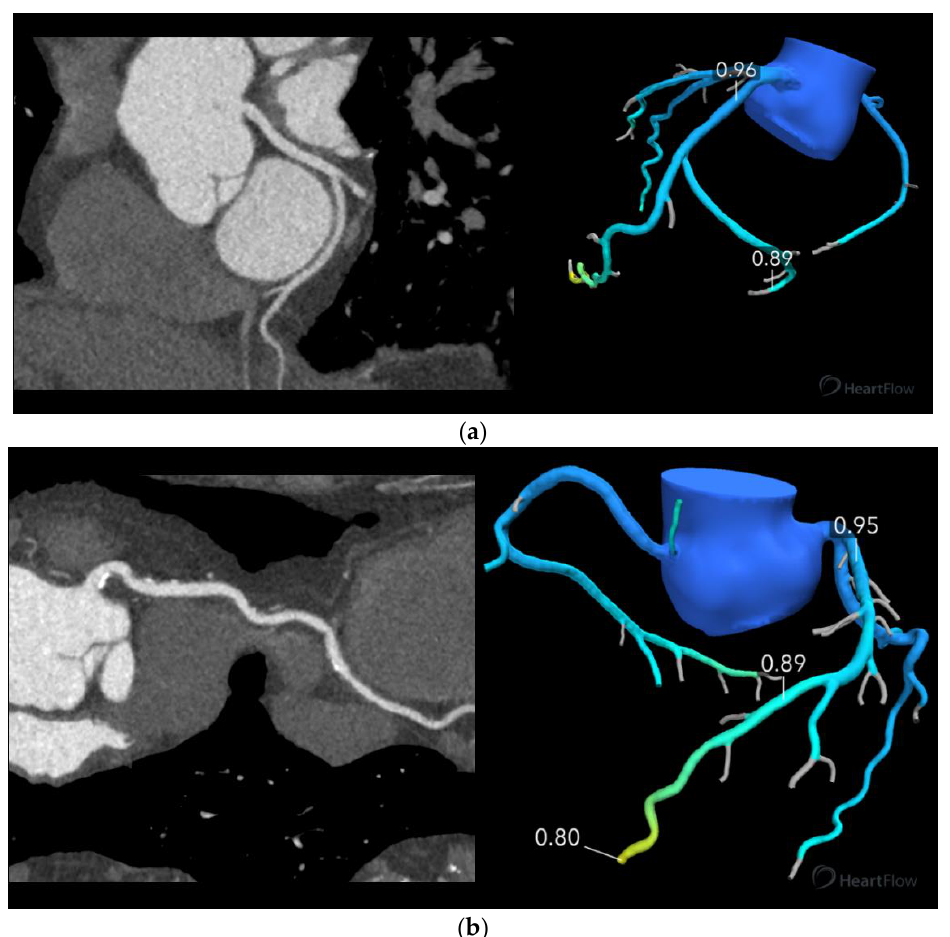
Figure 2. ( a ) CCTA of CX and corresponding FFRct. FFRct for CX is 0.89. ( b ) CCTA of LAD and corresponding FFRct. Nadir for FFRct on LAD is 0.80. Arrows showing mixed and soft plaque in CCTA images. Table 2. Comparison of mean fractional flow reserve (FFRct) by computed tomography angiography in all 3 main coronary arteries between the 2 groups.